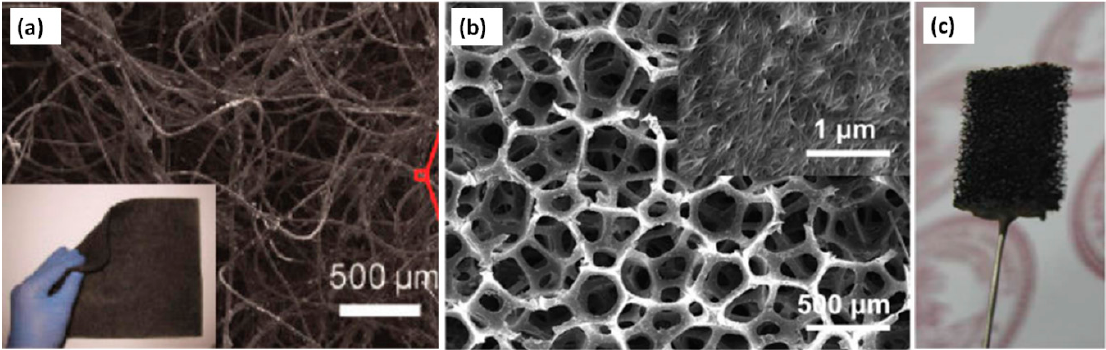
Figure 12. SEM micrographs of composite anode materials ( a ) CNT ‐ textile ( b ) CNT ‐ sponge ( c ) Picture of a CNT ‐ sponge electrode. Image (a): Reproduced with permission from [142]. Copyright ACS, 2011. Image (b) and (c): Reproduced with permission from [143]. Copyright RSC, 2012.